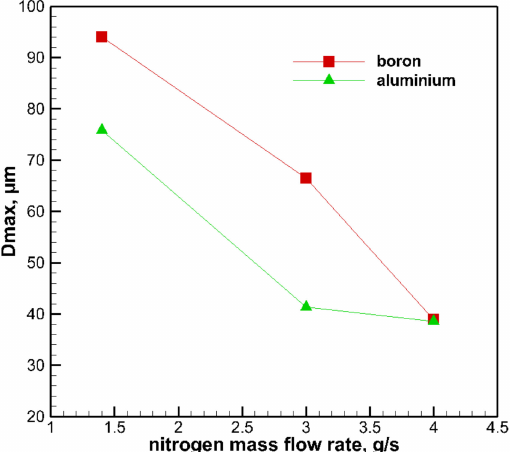
Figure 12. D max for gel fuels with different particle additions.